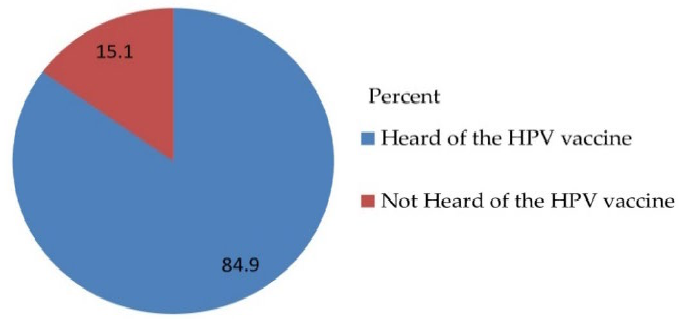
ation of ± 0.35833 (Figure 5).